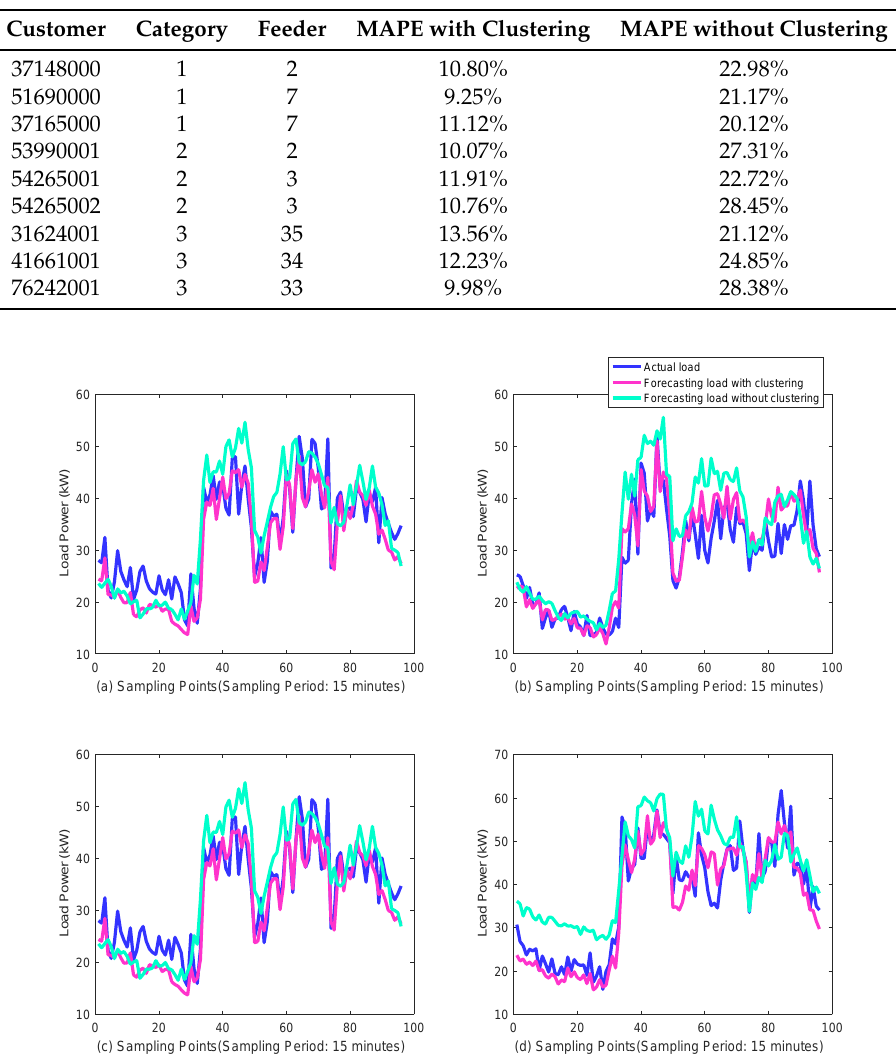
Figure 12. Compared curves of actual load and forecasting load of Customer 53990001 with or without clustering: ( a – d ) the results for four different days in November